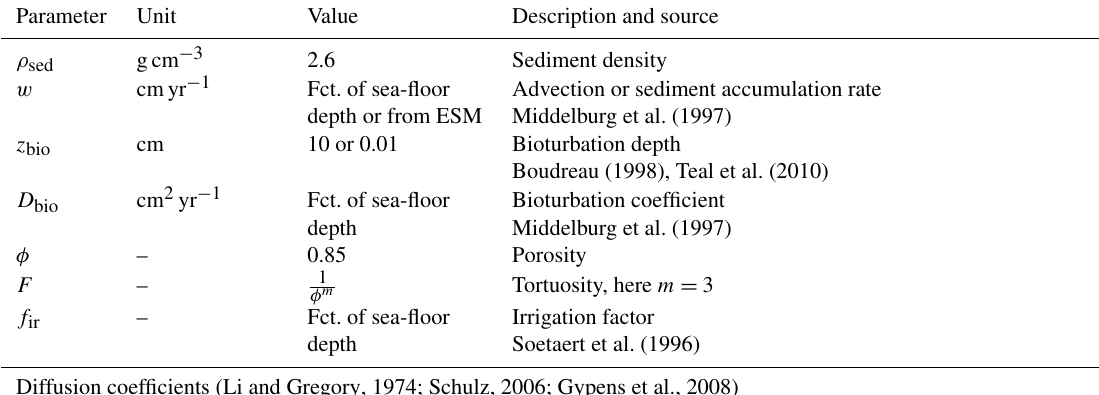
Table 9. Sediment characteristics and transport